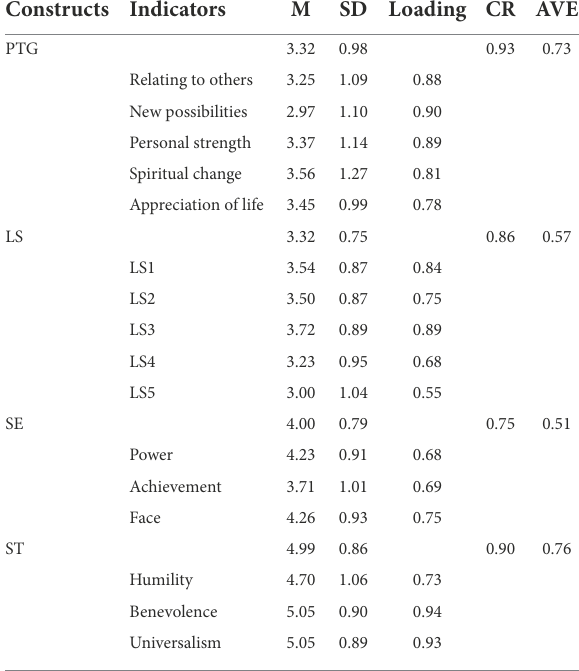
TABLE 1 Descriptive statistics, convergent validity, and construct reliability results.